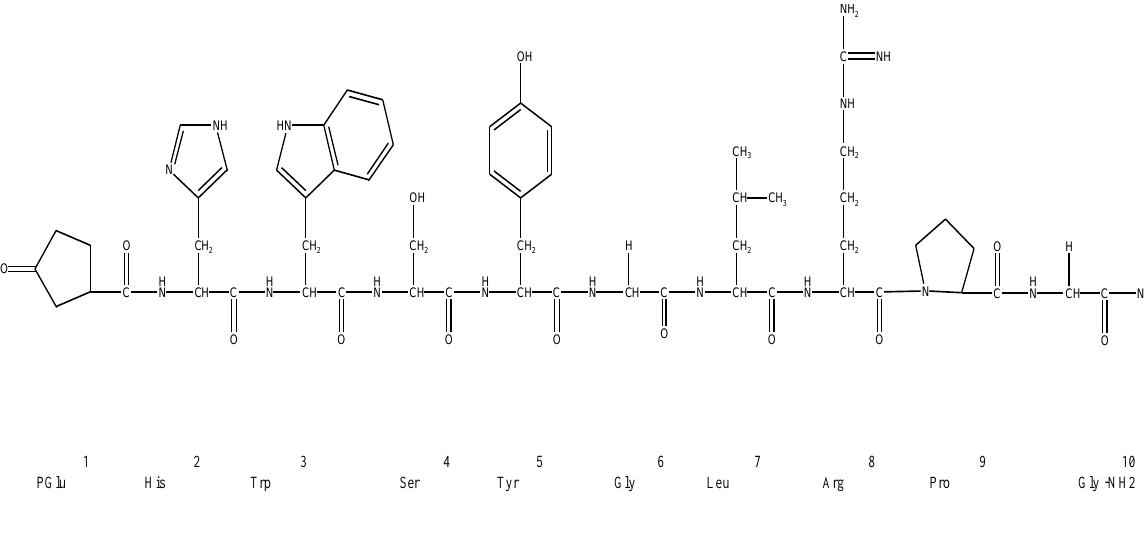
Figure1: Basic structure of Gn-RH hormone The gonadotropins have a close functional Fig. basic structure of Gn - RH relationship to estrogen, progesterone, and testosterone. They are called gonadotropins because of their action on the gonads. They control ovulation, spermatogenesis, and development of sex organs, and they maintain pregnancy. Included in this group GnRH, LH, FSH, Chorionic gonadotropin (CG; hCG is human gonadotropin), a glycoprotein produced by the placenta; its pharmacological actions are essentially the same as those of LH (4-9) . the gonadotropes in the anterior pituitary, gonadotropins LH and FSH.